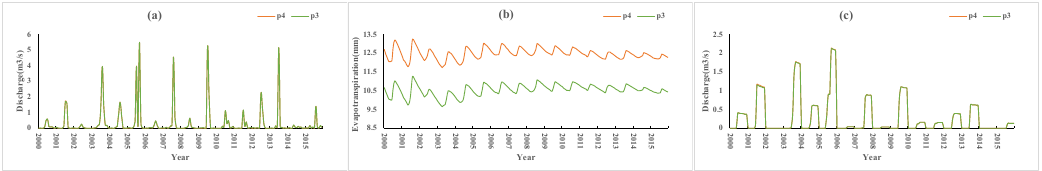
Figure 10. P2 vs. P1 simulation results: ( a ) surface runoff ( b ) evapotranspiration ( c ) farmland runoff.